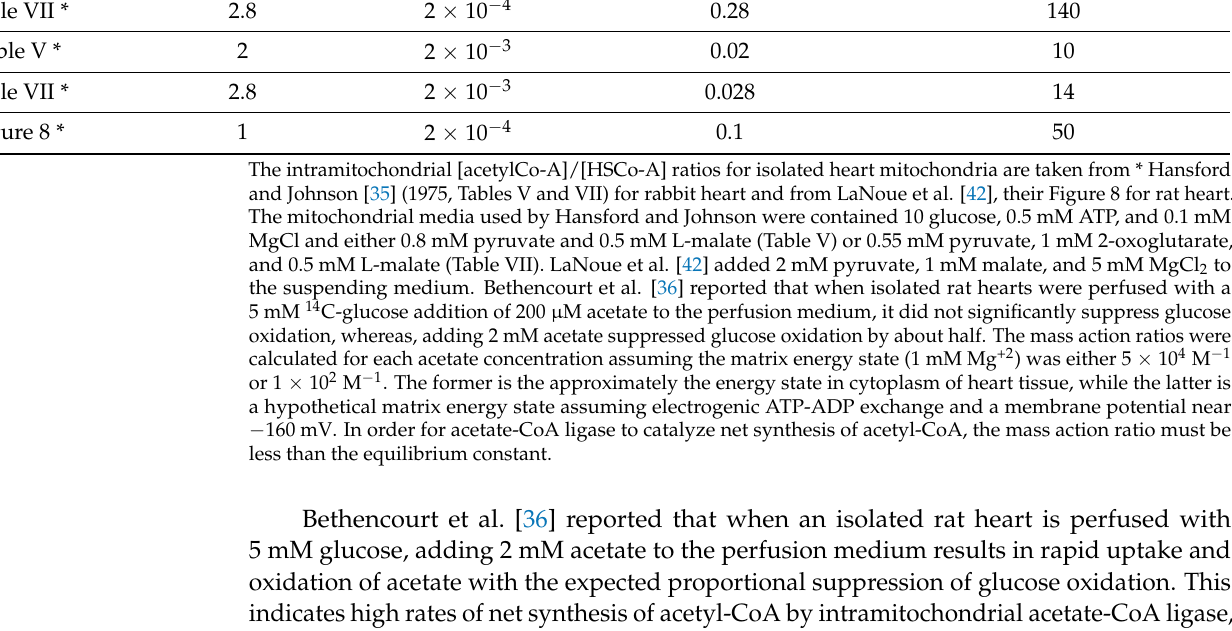
2 2.8 2 2 × 10 − 3 2.8 1 2 × 10 − 4 0.1